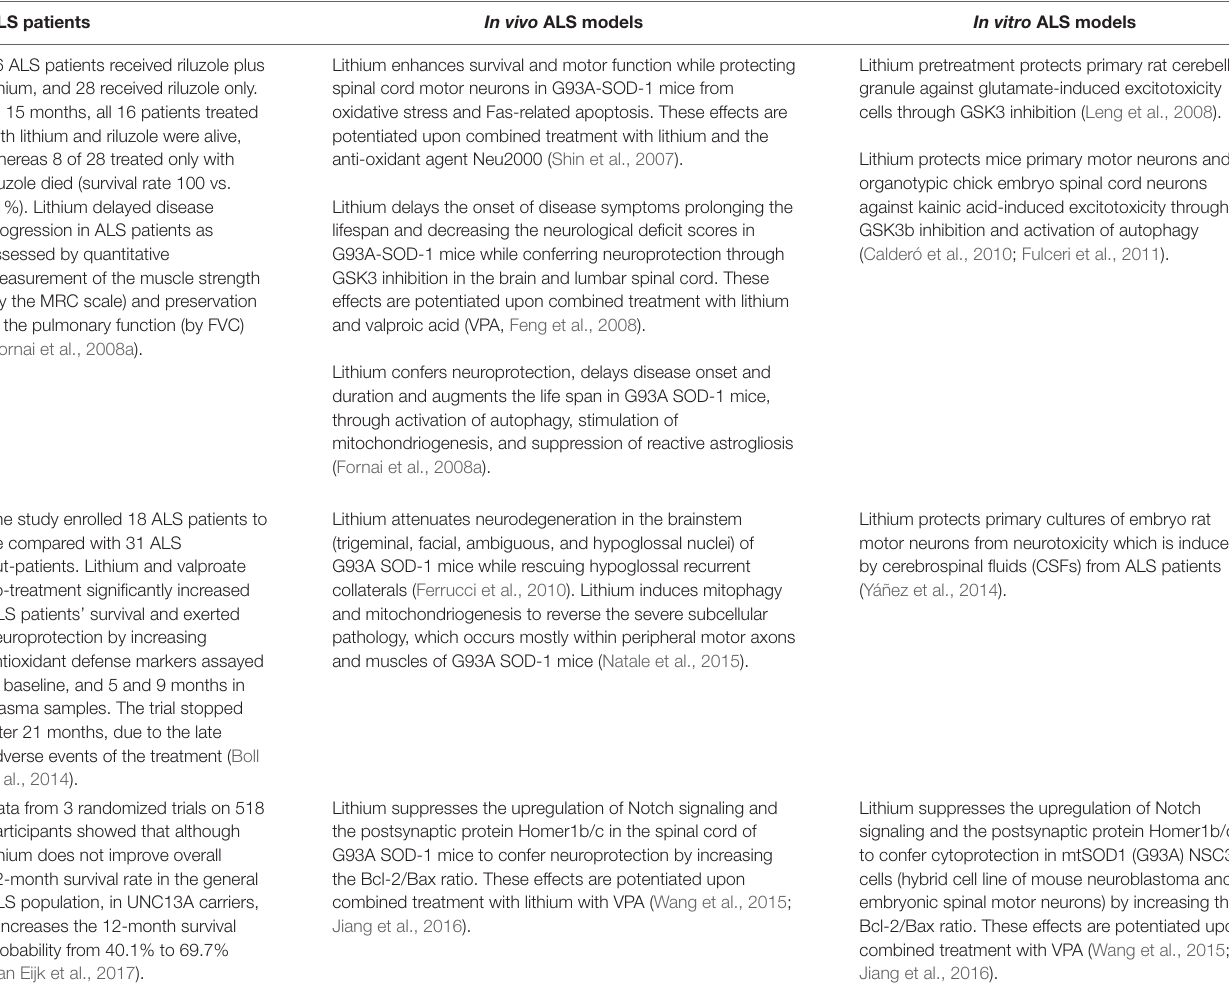
TABLE 1 | Clinical and experimental studies reporting beneficial effects of lithium in